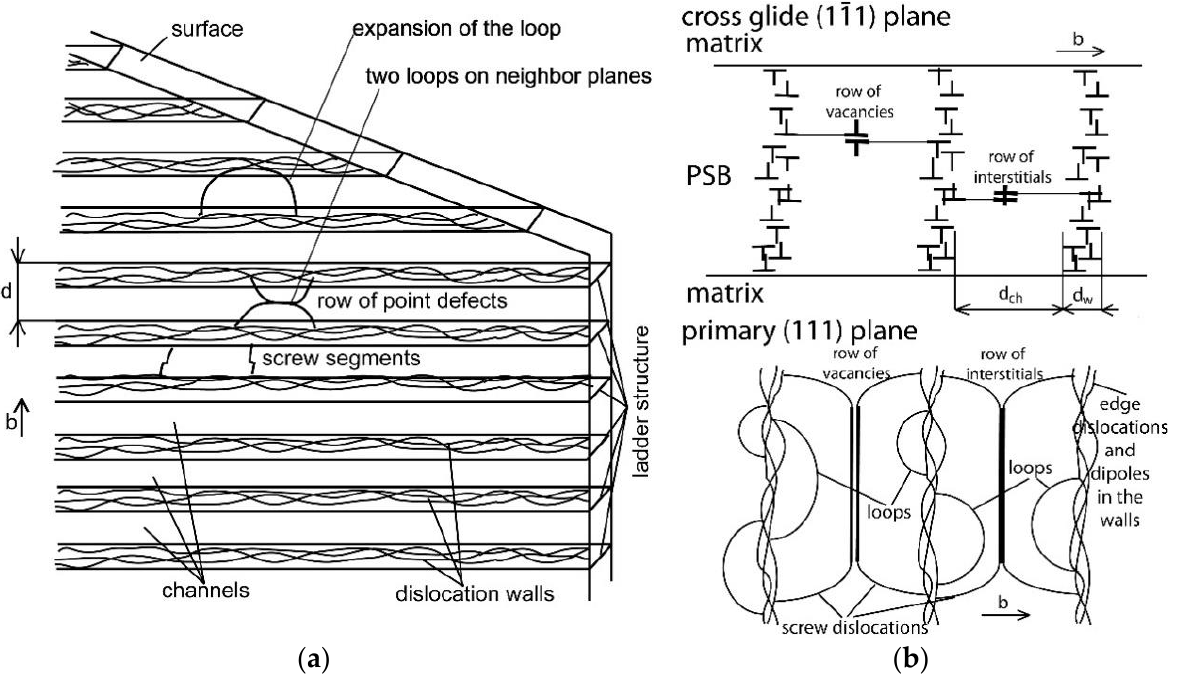
Figure 10. Schematics of ladder-like dislocation arrangement in PSB ( a ) and interaction od dislocations producing point defects in primary slip plane of PSB ( b ).